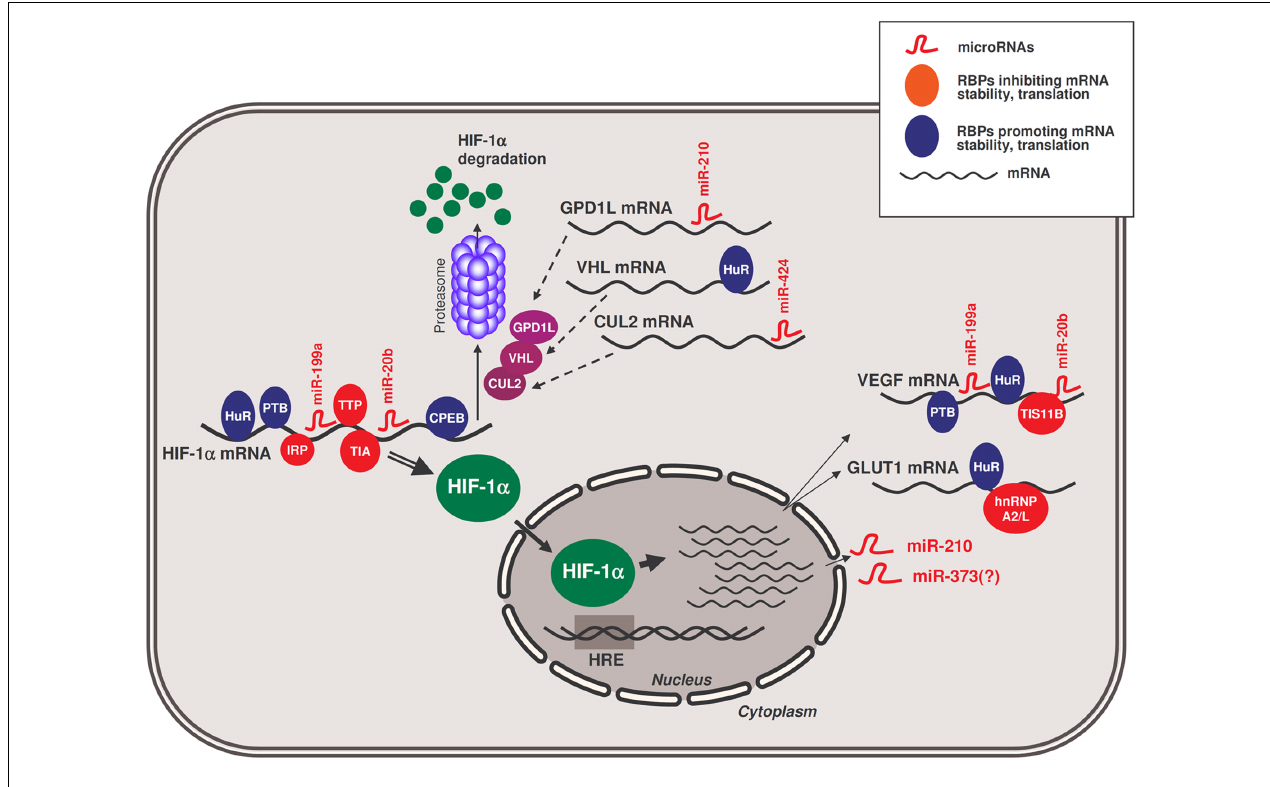
those that encode microRNAs like miR-210 and likely also miR-373. In turn, miR-210 can modulate the production of HIF-1 α by repressing the production of GPD1L; other RBPs and other microRNAs assist in modulating the expression of additional HIF-1 α stability regulators (e.g.,VHL, CUL2), and other hypoxia-response proteins like GLUT1